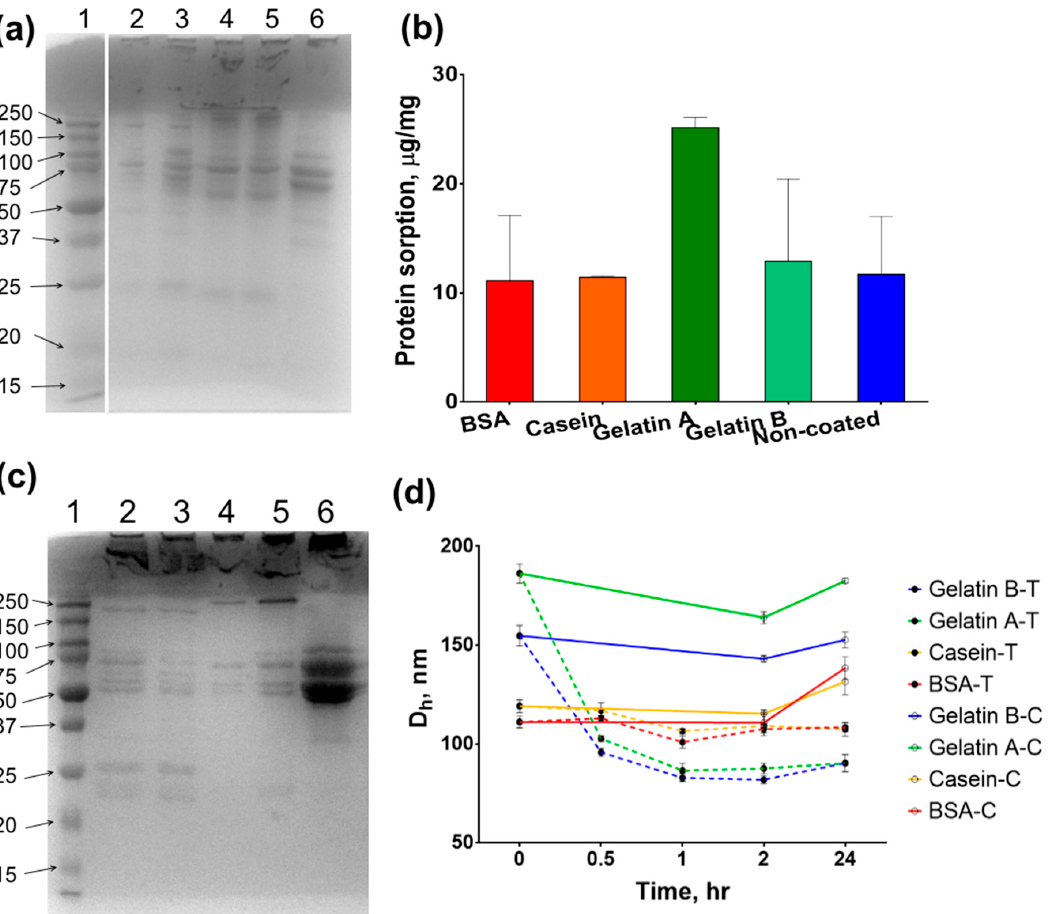
Figure 10. Protein corona and stability of nanoclusters to proteolysis. Protein coronas of Fe@C-NH 2 /BSA/Str (lane 2), Fe@C-NH 2 /Casein/Str (lane 3), Fe@C-NH 2 /Gelatin A/Str (lane 4), Fe@C-NH 2 /Gelatin B/Str (lane 5), and Fe@C-NH 2 (lane 6) in blood serum ( a ) and plasma ( c ), with lane 1-protein markers (kDa). ( b ) The sorption of serum proteins on Fe@C-NH 2 /Protein/Str and Fe@C-NH 2 . ( d ) The size of Fe@C-NH 2 /Protein/Str after incubation in the trypsin solution (dashed line, filled circles) or PBS (solid line, open circles). Coating: BSA (red), casein (yellow), gelatin A (green) and B (blue), n = 3, mean ± SD.